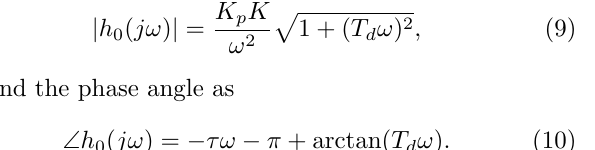
Figure 3: Input unit step disturbance, reference is zero. PD controllers for a DIPTD plant with K = 1 and τ =